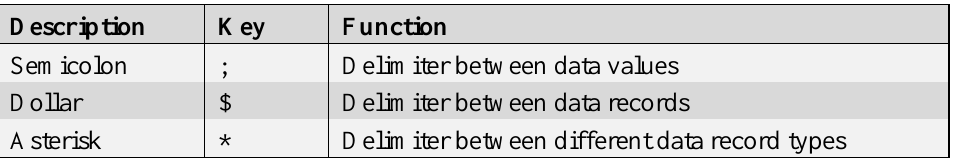
Table 2. General delimiter description.